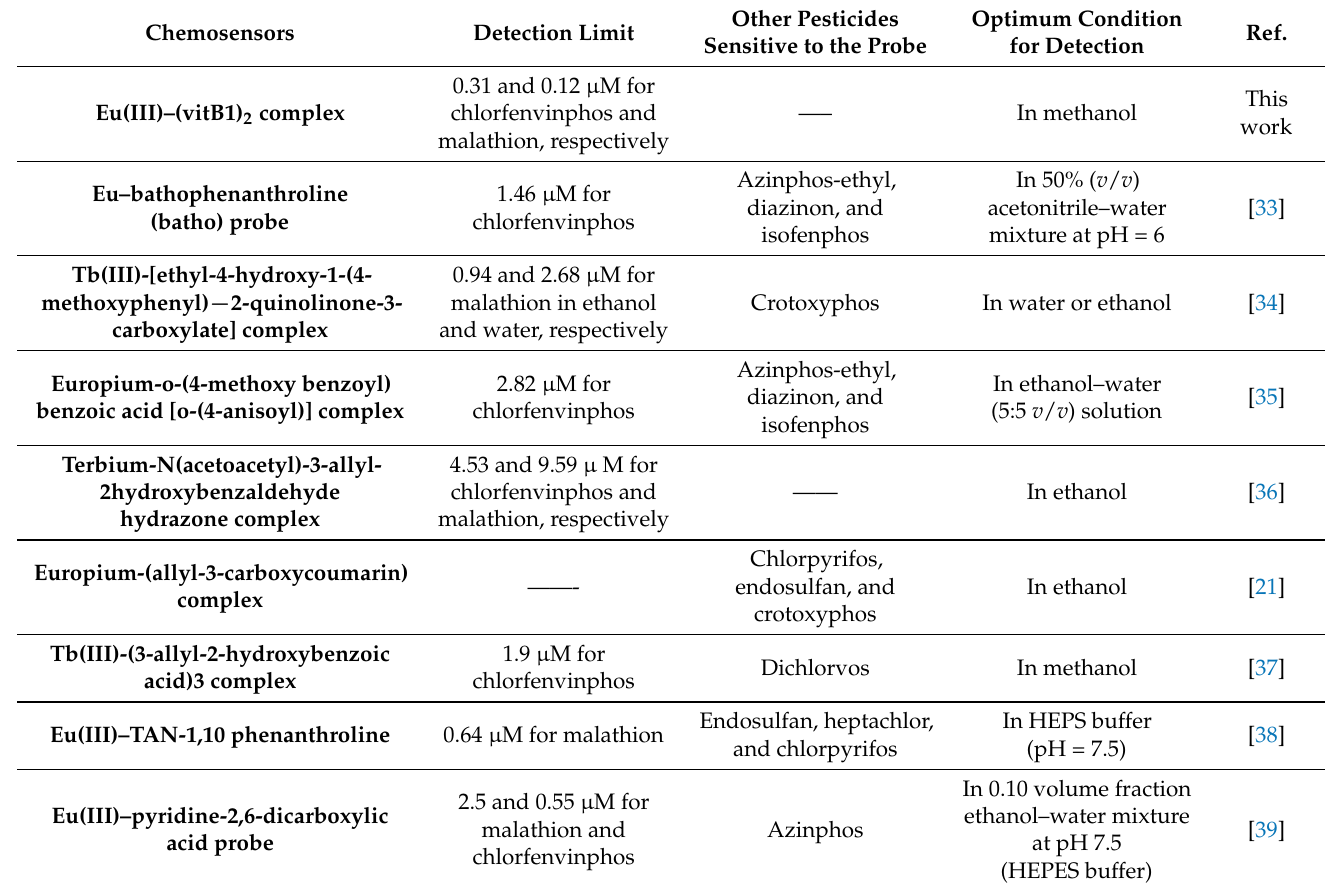
Table 3. A comparison of luminescent lanthanide complexes as chemosensors for chlorfenvinphos and malathion